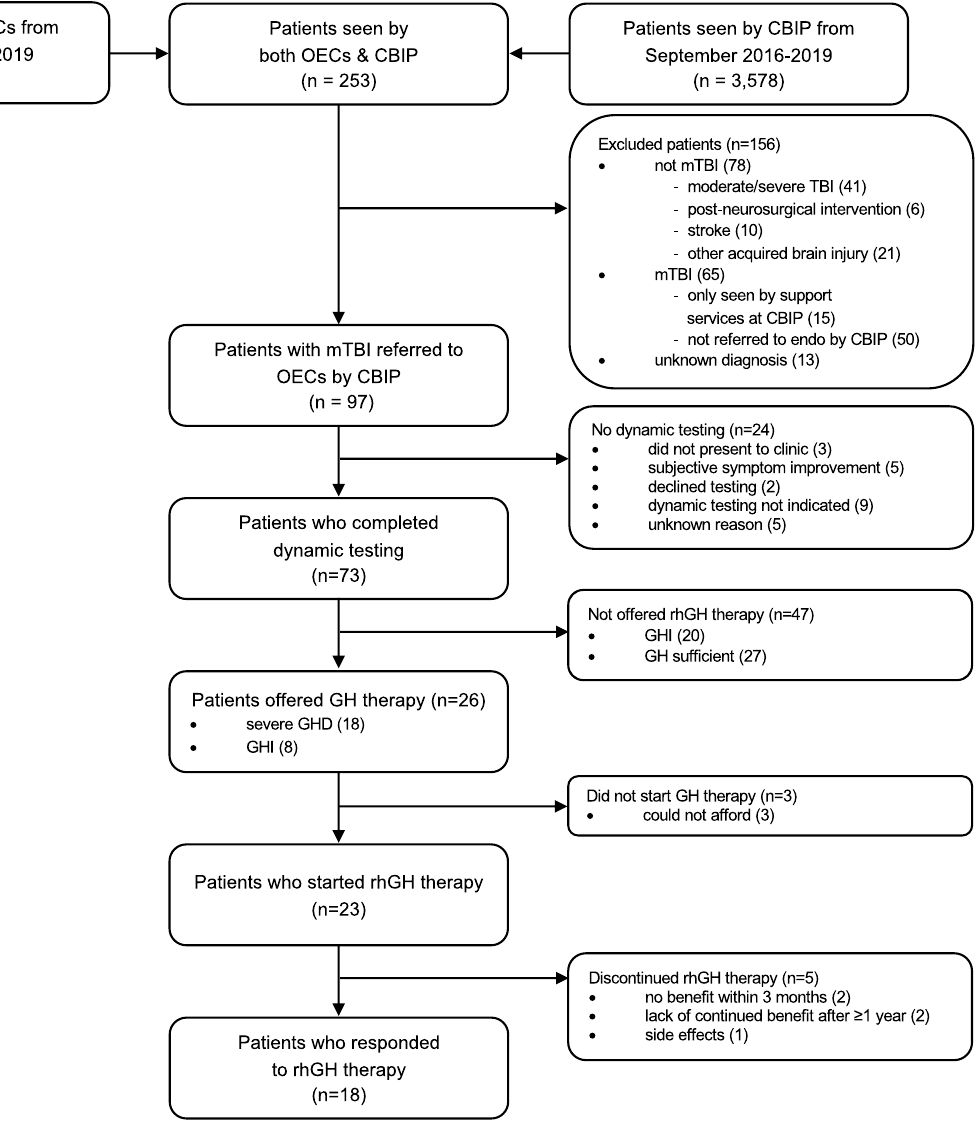
Figure 1. Flowchart of referral to endocrinology, GH testing and rhGH therapy. CBIP Calgary Brain Injury Program (outpatient brain injury clinic), GH growth hormone, GHD growth hormone deficiency, GHI